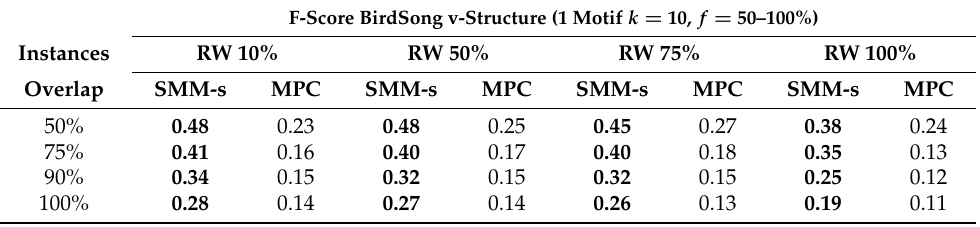
Table 9. F-scores for time series with recurring patterns that are not variate-aligned from